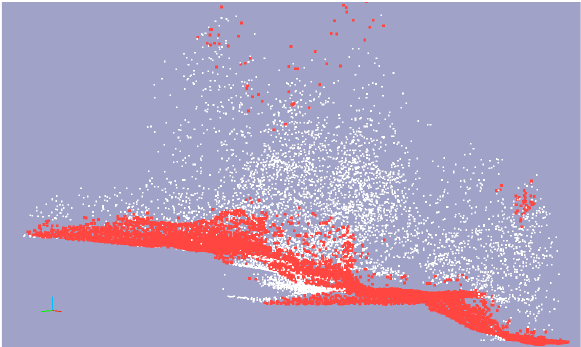
Figure 6. The points remaining after three iterations of roughness segmentation (pink) inside the complete point cloud, (white). Some vegetation remains at this stage. However, the remaining vegetation is well separated from both the terrain and the standing structures.